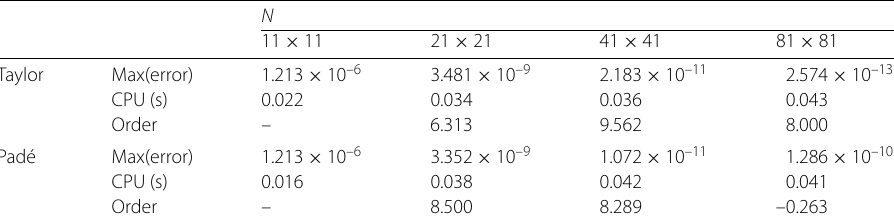
Table 7 Numerical results of two-dimensional parabolic problem with time step size τ = 5 × 10 –5 at t = 0.1 for case 2 of Example